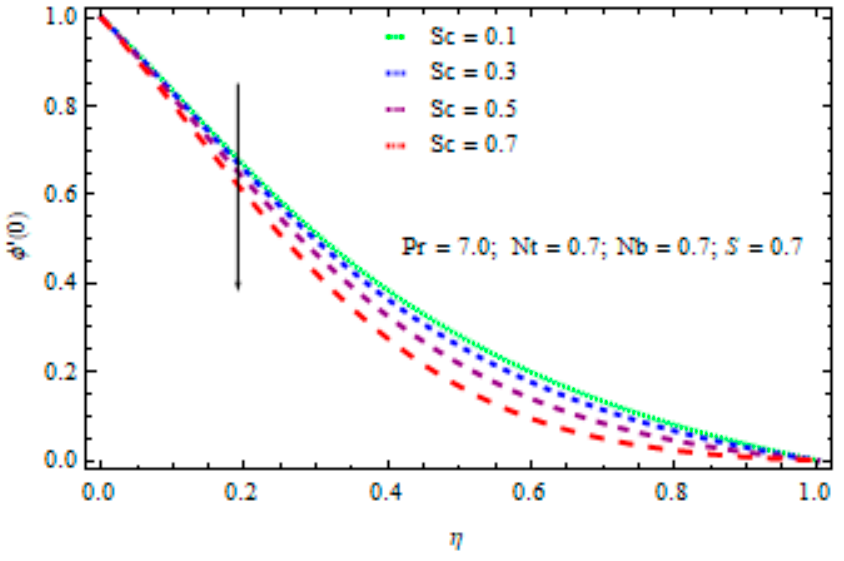
Figure 18. The impact of the Sc parameter on the Sherwood number.